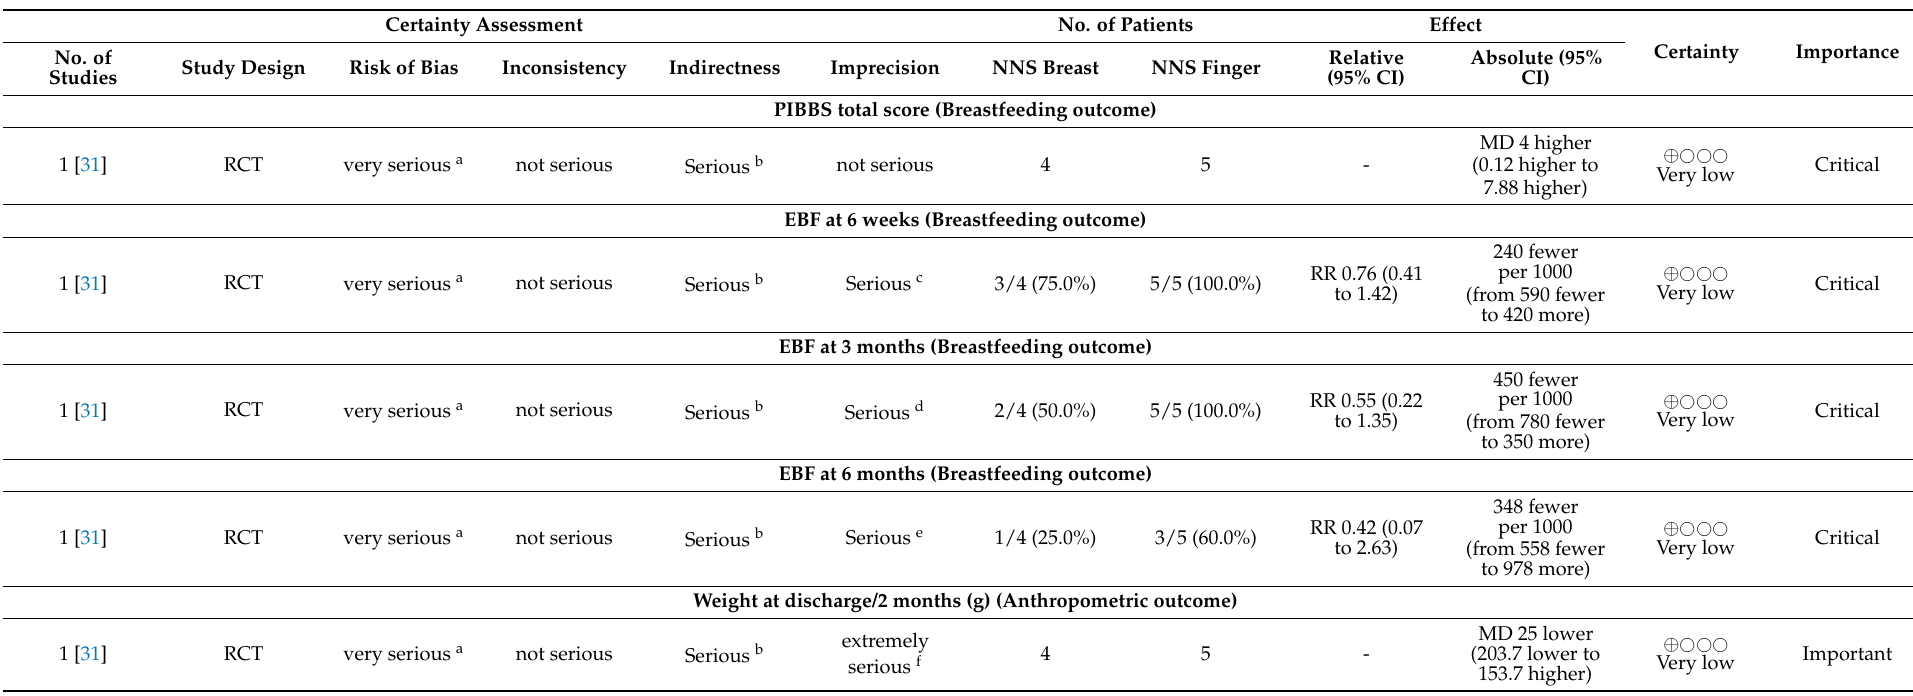
Table 2. GRADE evidence profile: Non-nutritive suckling (NNS) on breast compared to NNS on finger for infants u6m with growth faltering. Certainty